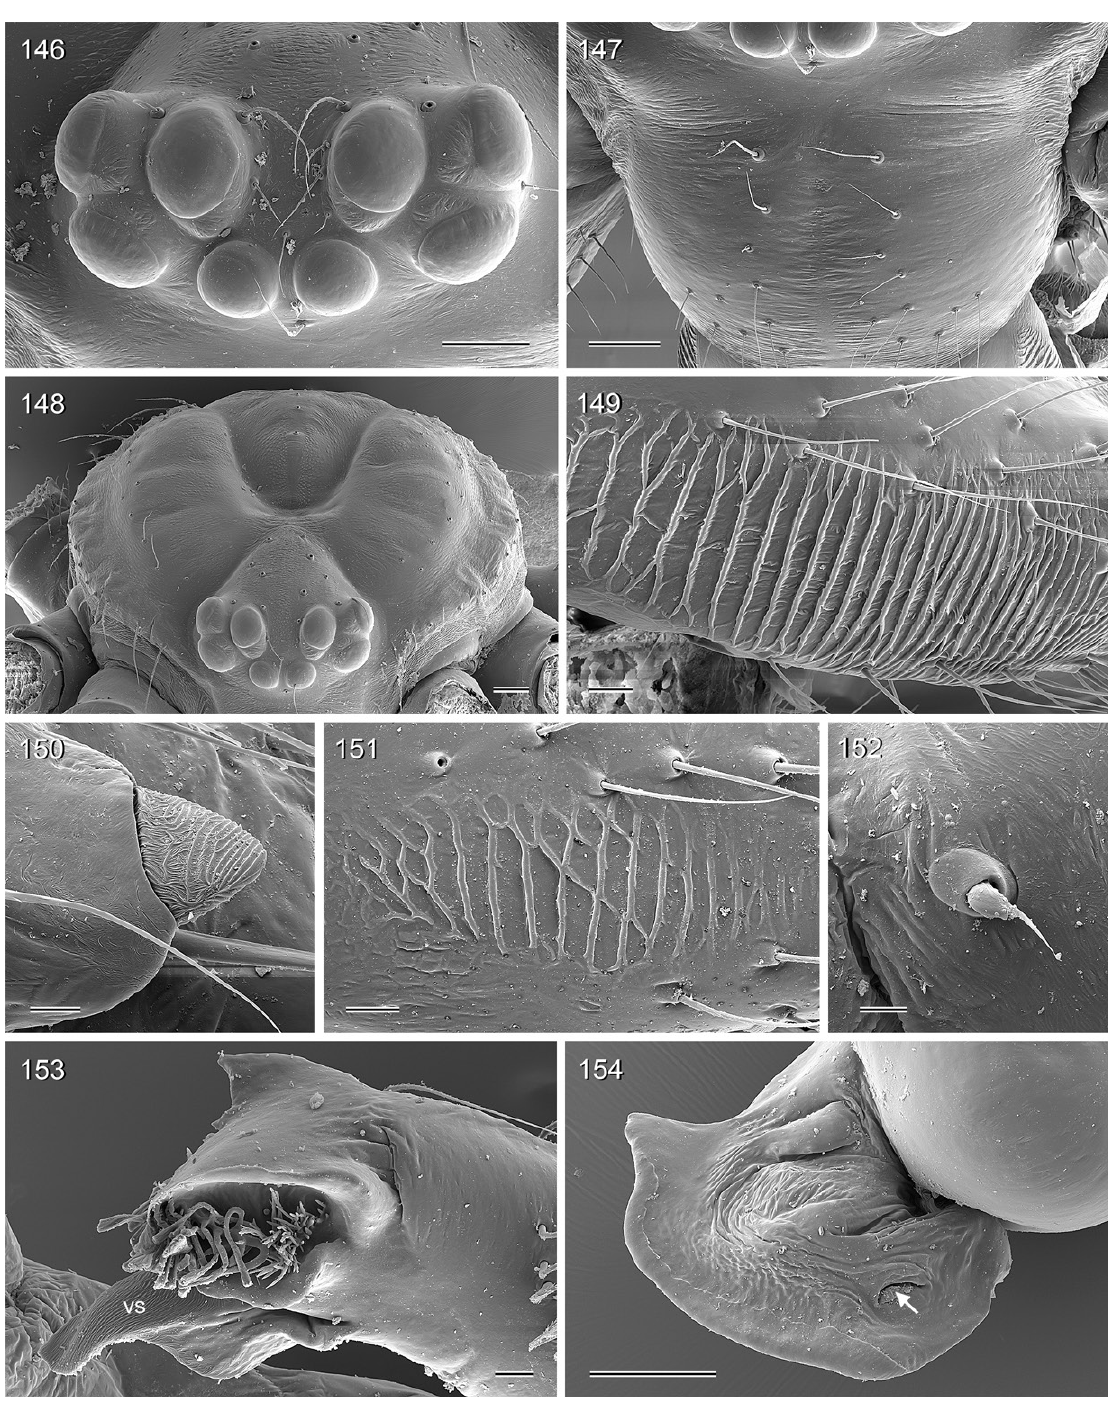
Figs 146–154. Holocnemus hispanicus Wiehle, 1933; male and female from Spain, Huelva, “Alájar/ Aracena” (MHNG). 146 . Male ocular area. 147 . Male clypeus. 148 . Female carapace and ocular area. 149 . Male cheliceral stridulatory file. 150 . Tip of male cheliceral apophysis. 151 . Female cheliceral stridulatory file. 152 . Stridulatory pick on female palpal femur. 153 . Left procursus, retrolateral-ventral view. 154 . Distal (main) sclerite of left genital bulb, prolateral (slightly distal) view; arrow: sperm duct opening. Abbreviation: vs = ventral sclerite. Scale bars: 146–148, 154 = 100 µm; 149, 151, 153 = 20 µm; 150, 152 = 10